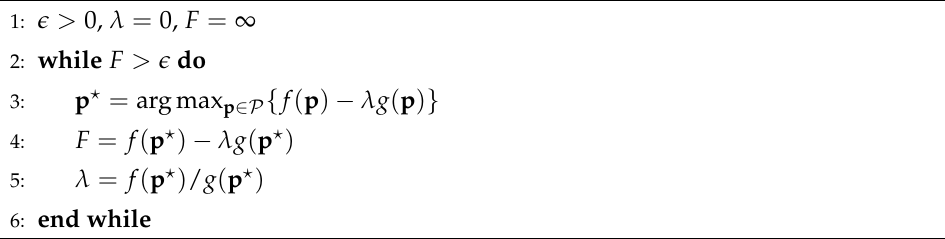
Algorithm 1 Optimal power control for GEE and MMF-EE (Dinkelbach’s